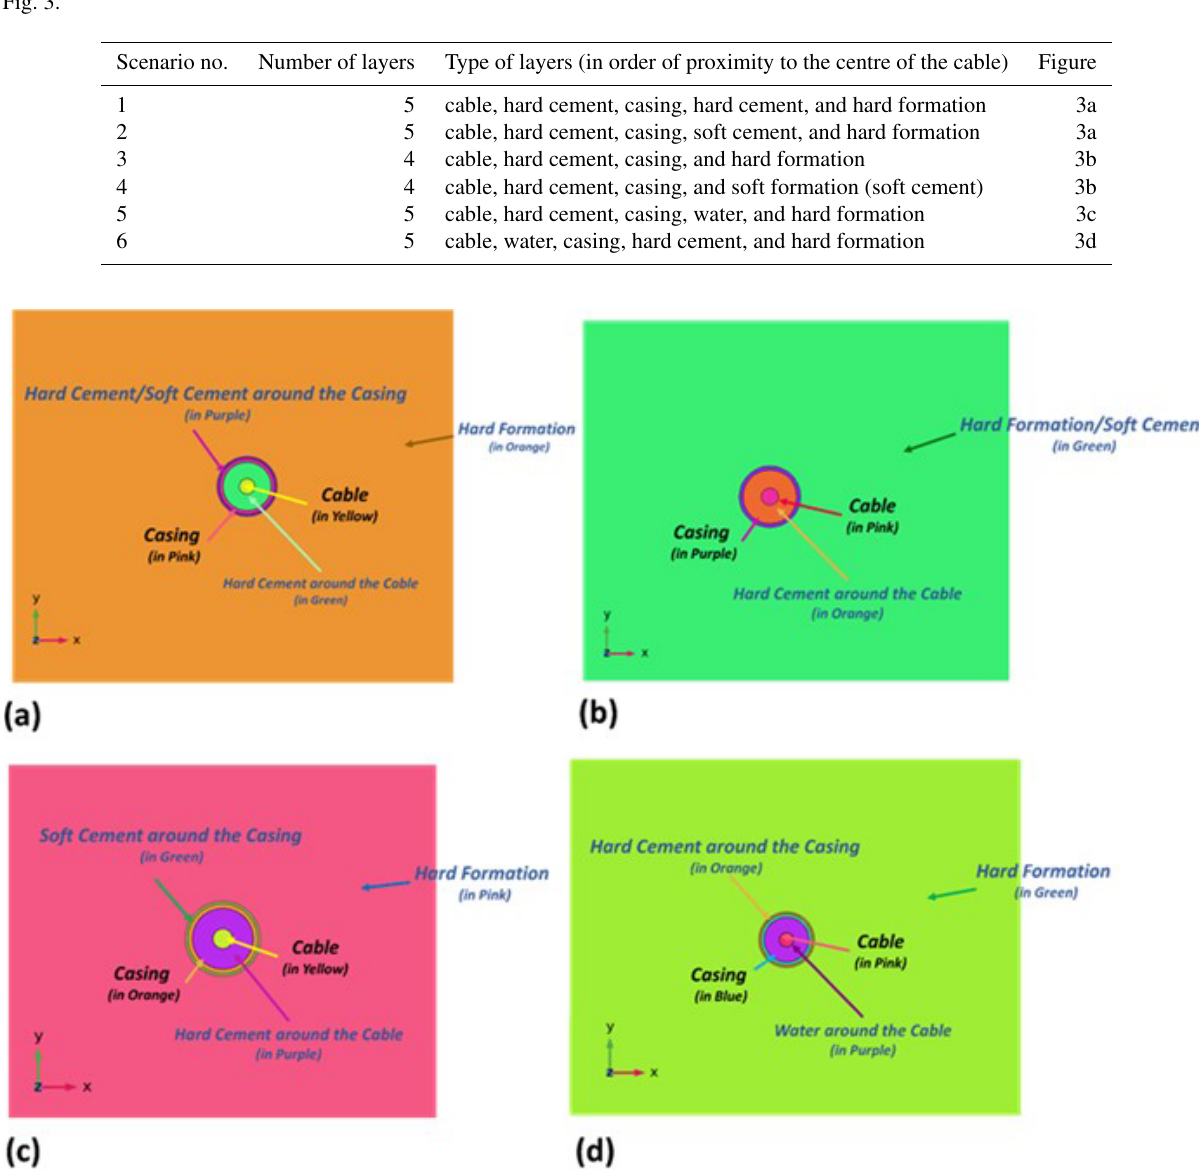
Figure 3. The 3D model geometries for various scenarios: (a) scenarios 1 and 2, (b) scenarios 3 and 4, (c) scenario 5, and (d) scenario